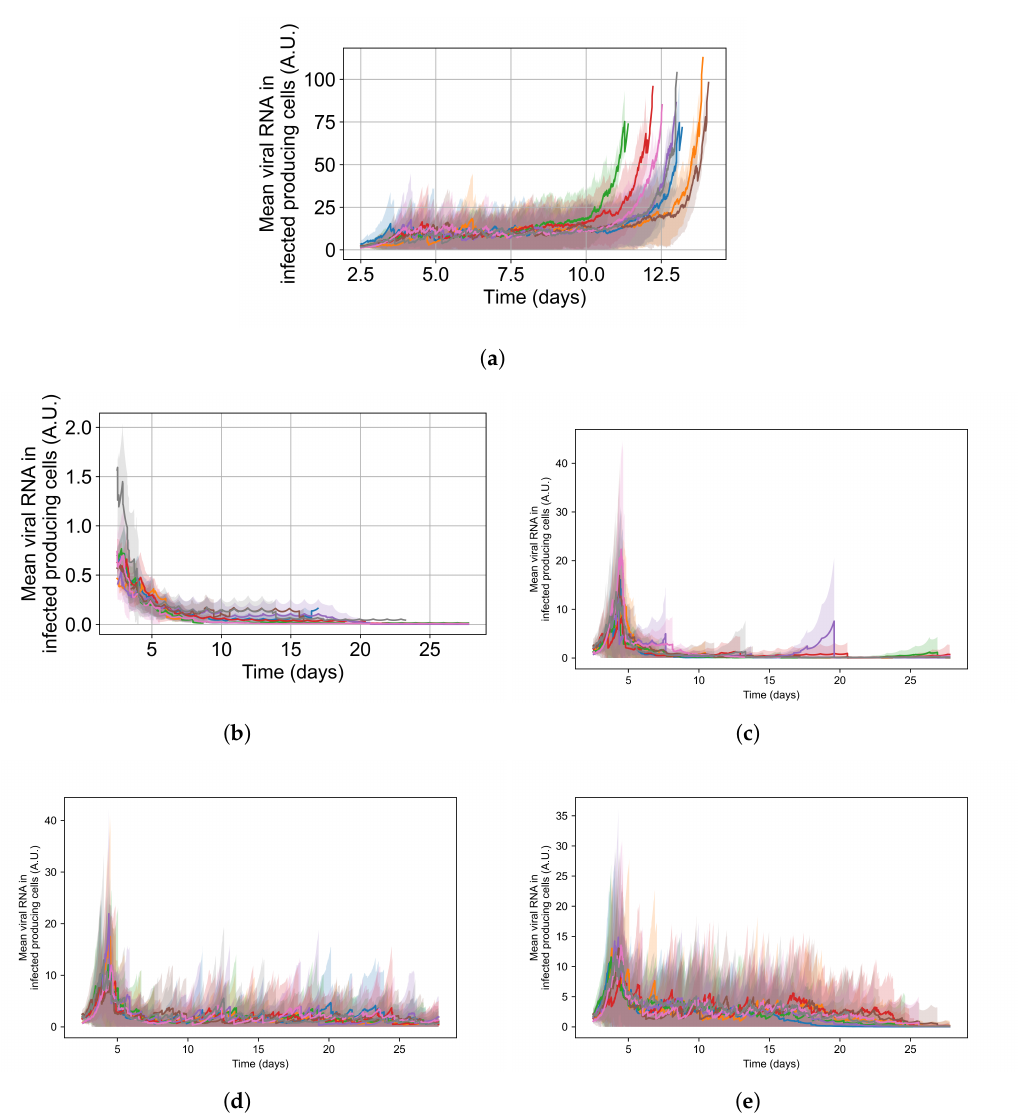
Figure 15. Mean RNA levels in virus-releasing infected cells (solid lines) with standard deviation (shaded regions) versus time for individual simulation replicates under different simulation options: ( a ) is untreated, ( b ) is treated with no metabolic heterogeneity, ( c ) is treated with a metabolism standard deviation of 0.1, ( d ) is treated with a metabolism standard deviation of 0.25, and ( e ) is treated with a metabolism standard deviation of 0.5. Please note that the y-range in ( a , b ) differs from the